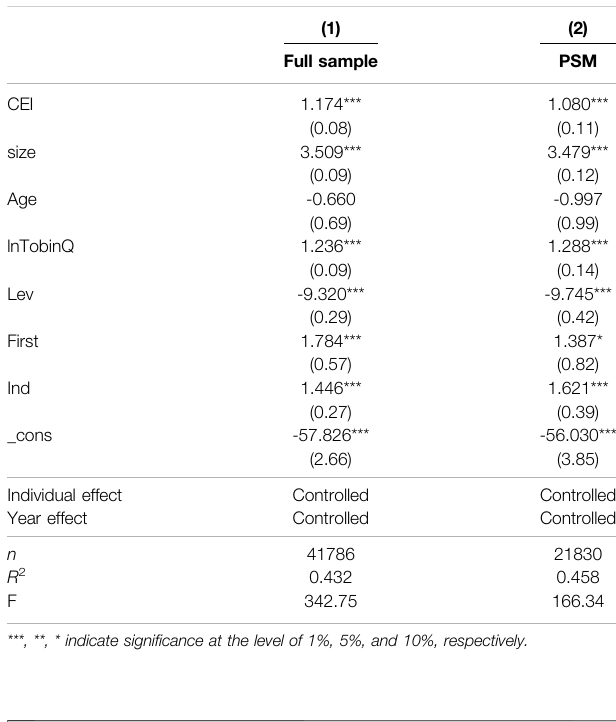
TABLE 8 | Innovation-driven mechanism.